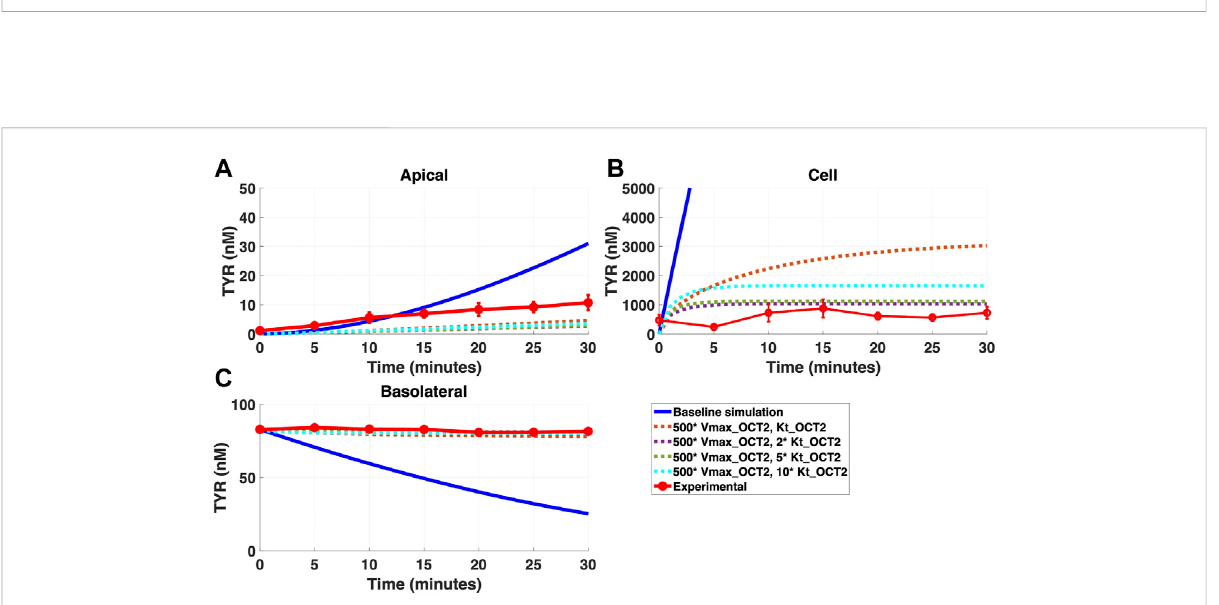
FIGURE 6 Introduction of a non-OCT2 facilitated diffusion transporter to the Caco-2 basolateral membrane improves model accuracy following basolateral TYR loading. The transport of 82.9 nM TYR across Caco-2 cells was modeled following basolateral loading by solving Eqs 4 – 8, using the values mentioned in Supplementary Table S2, using MATLAB vR 2021a. Comparisons were made between the models (baseline = blue curve; modi fi ed = dotted curves) and experimental observations; red curve (Sarkar and Berry, 2020)for the apical Panel 6 (A) , cellular Panel 6 (B) and basolateral compartments Panel 6 (C) . Good agreement with experimental observations were obtained at V max = 50 nM/s (500*V max _ OCT2 ) and K t = 507.5 – 1,015 nM (5 – 10 *K t_OCT2 ). Kinetic parameters used for this modelling were: V max_OCT2 = 0.1 nM/s, K t _OCT2_apicaltocell = 101.5